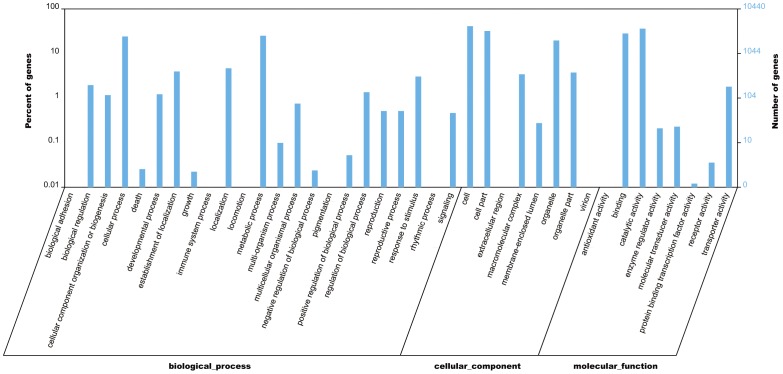
GO annotation of non-redundant unigenes.Good hits were aligned to the GO database, and 10,440 transcripts were assigned to at least one GO term. All the unigenes were grouped into three major functional categories, namely biological process, cellular component, and molecular function. The right y-axis indicates the number of unigenes in a category. The left y-axis indicates the percentage of a specific category of unigenes in that main category.